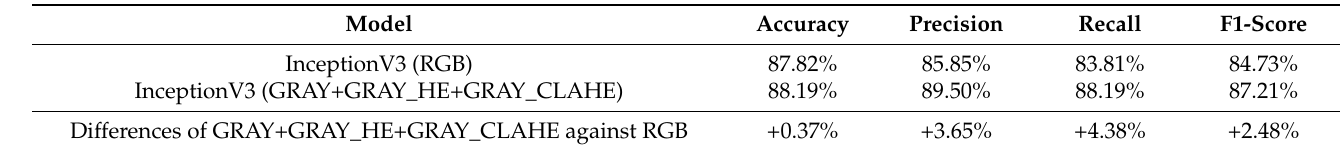
Table 13. Comparison between the average performance of the InceptionV3 model on RGB and GRAY+GRAY_HE+GRAY_CLAHE image representations.